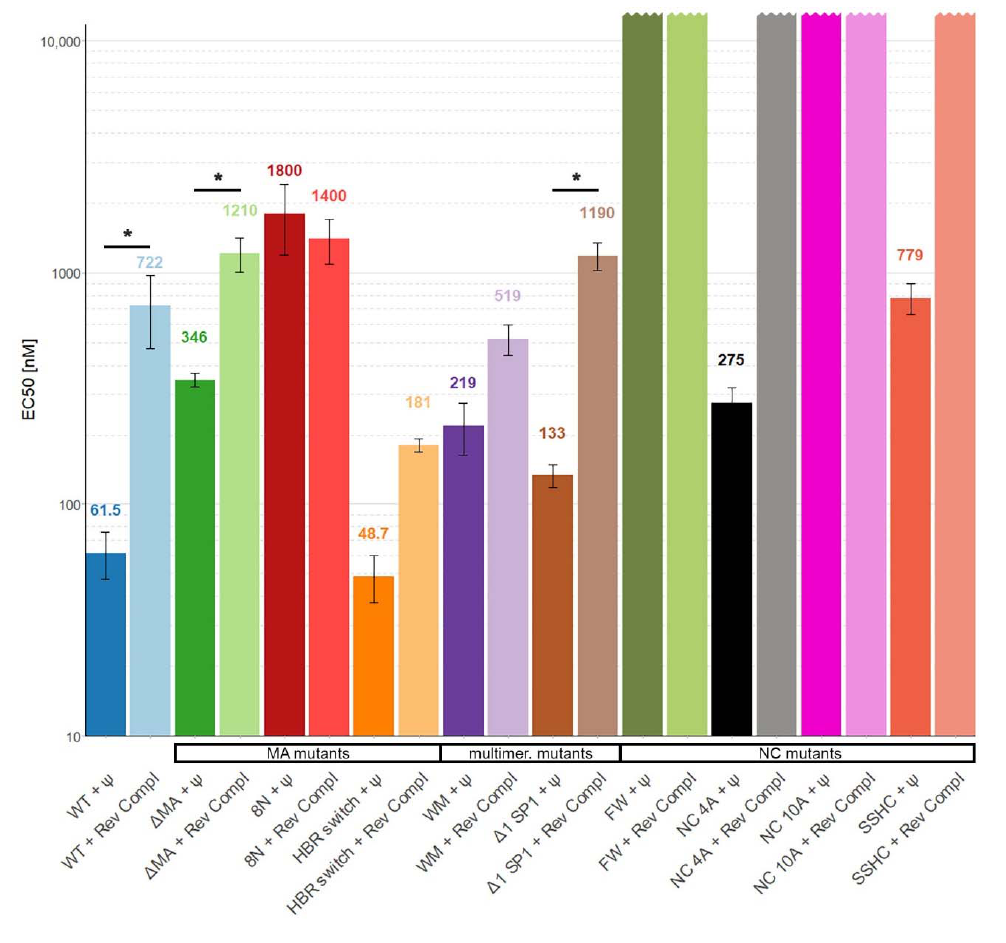
Figure 3. The affinity of WT Gag Δ p6 and mutants to Ψ and reverse complement RNAs in buffer with Figure 3. The a ffi nity of WT Gag ∆ p6 and mutants to Ψ and reverse complement RNAs in bu ff er with 300 mM NaCl. *, p < 0.05. Error bars represent 95% confidence interval of EC50 values. 300 mM NaCl. *, p < 0.05. Error bars represent 95% confidence interval of EC50